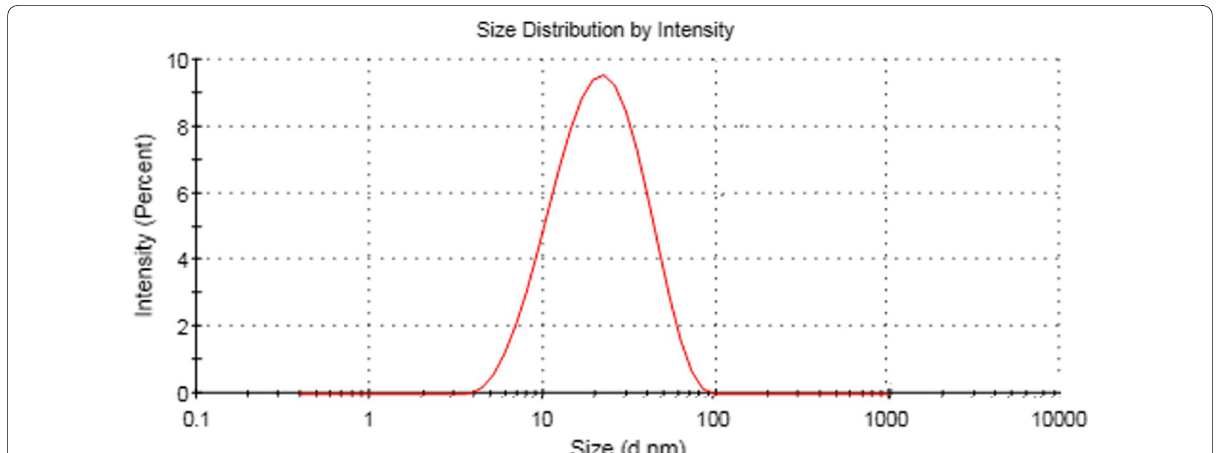
Fig. 6 Particle size distribution of DC‑MNPs by DLS showing a particle size of 69.55 value of 0.283 ±